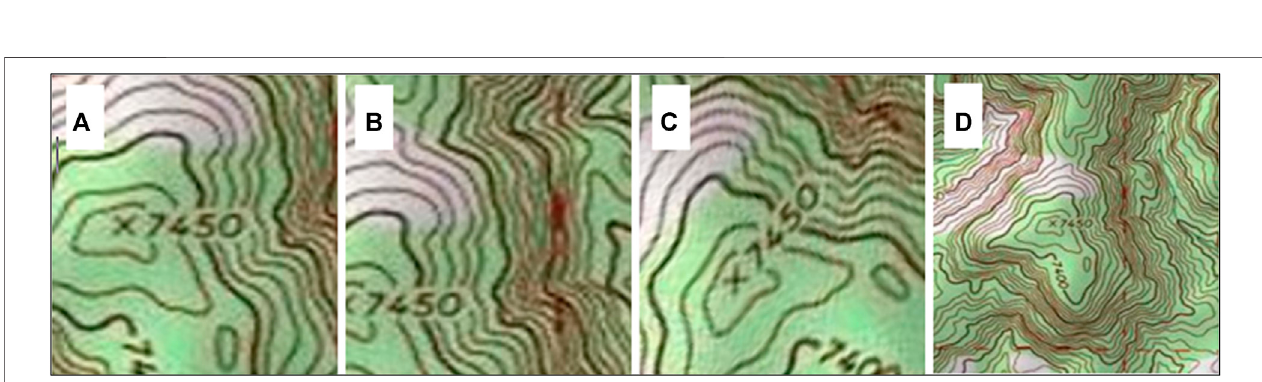
FIGURE 6 | Examples of each augmentation type for spotElev_Num84: (A) original centred, (B) offset 0.001 ° NE in latitude and longitude, (C) rotated 48 ° counterclockwise, and (D) scaled at 1:12,000.